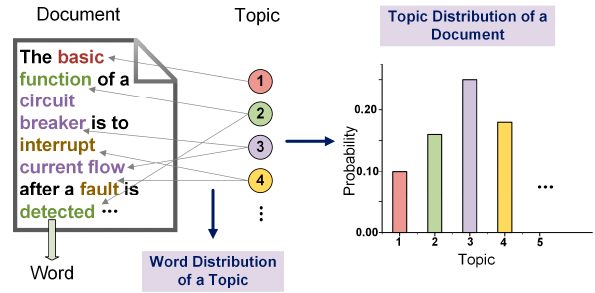
Figure 3. An illustrating example of Latent Dirichlet Allocation (LDA).